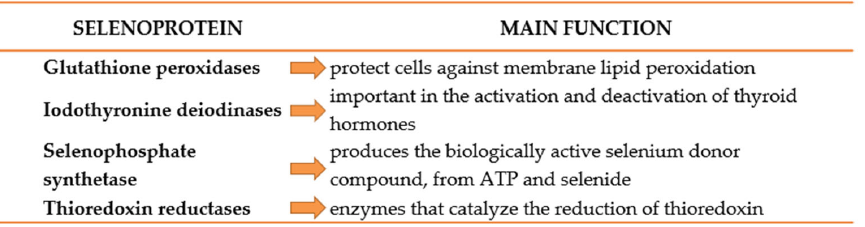
Table 3. The correlation between AD and selenium neuroprotective potential.